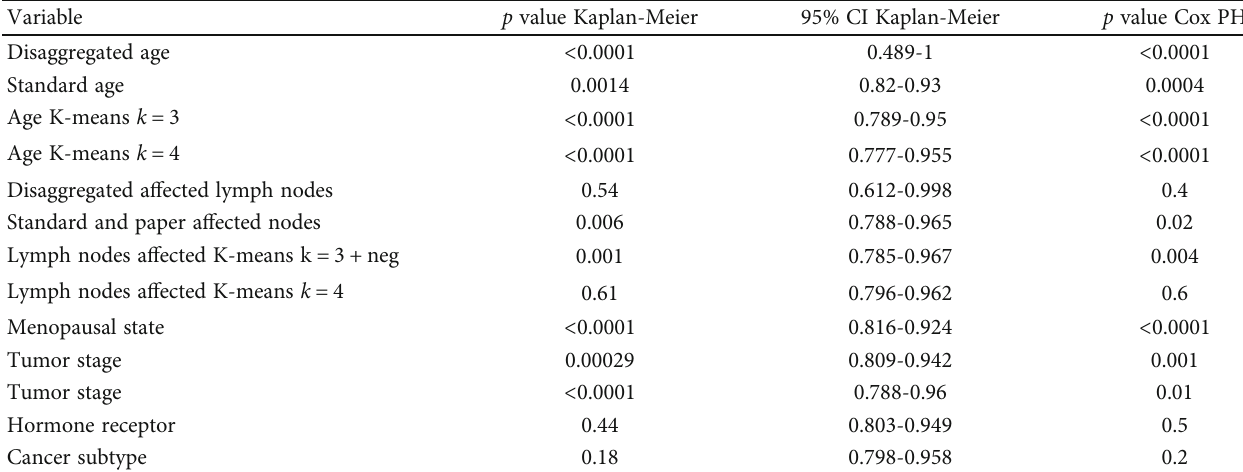
Table 6: Quality analysis of TCGA variables from p value and 95% CI.